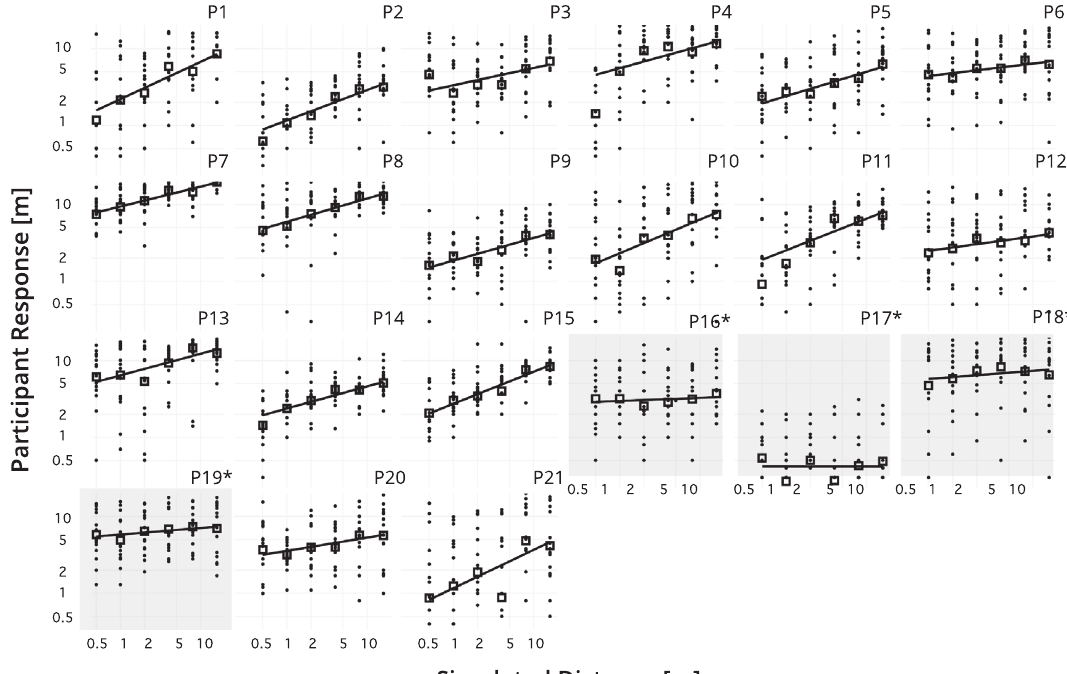
Figure 2. Perceived distances as functions of simulated distances for different participants. Each point indicates a single participant response. Squares represent geometric means. The solid curves show the power functions fi tted to geometric means. Participants whose responses were eliminated from further analysis are shown with gray boxes.